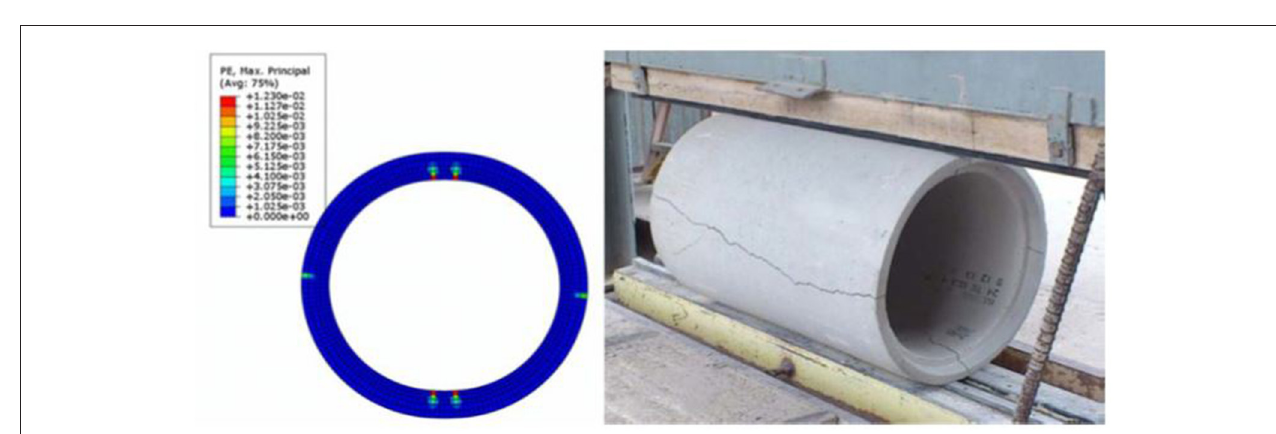
FIGURE 10 | Crack propagation in the bare concrete beam.